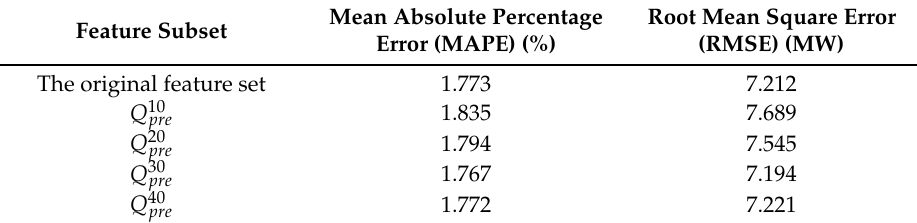
Table 5. Prediction error of different feature subsets selected for day-ahead